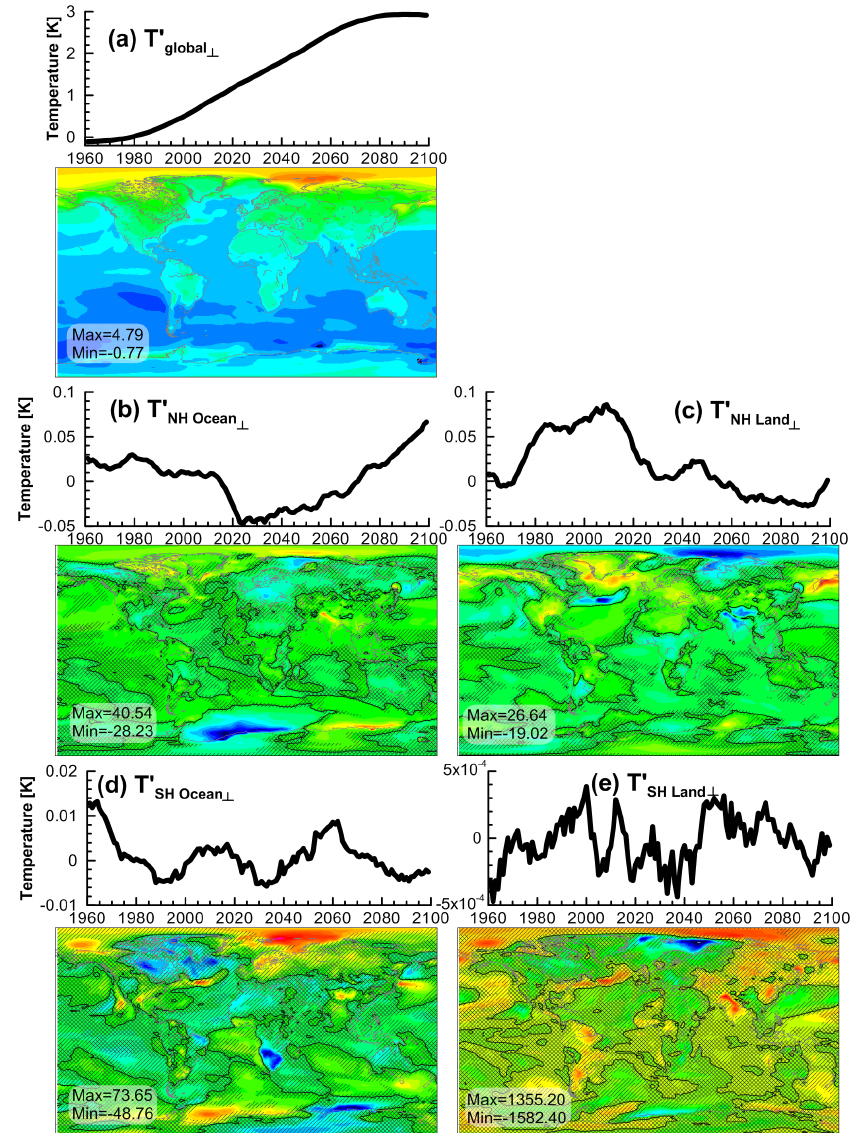
Fig. 6. Plots of the orthogonalised T 0 time series from the RCP 4.5 simulation of T 0 max together with their associated annual mean x ⊥ regression model fit coefficients. ⊥ denotes that the basis functions have been orthogonalised. Double hatching shows where the coefficients are not statistically significantly different from zero at the 1 σ level and single hatching where they are not different from zero at the 2 σ level. The thin black line on each map indicates the 0.0 value. Minimum values are shown in blue and pass through cyan, green, yellow and orange to maximum values in red (see lower left corner in each panel).